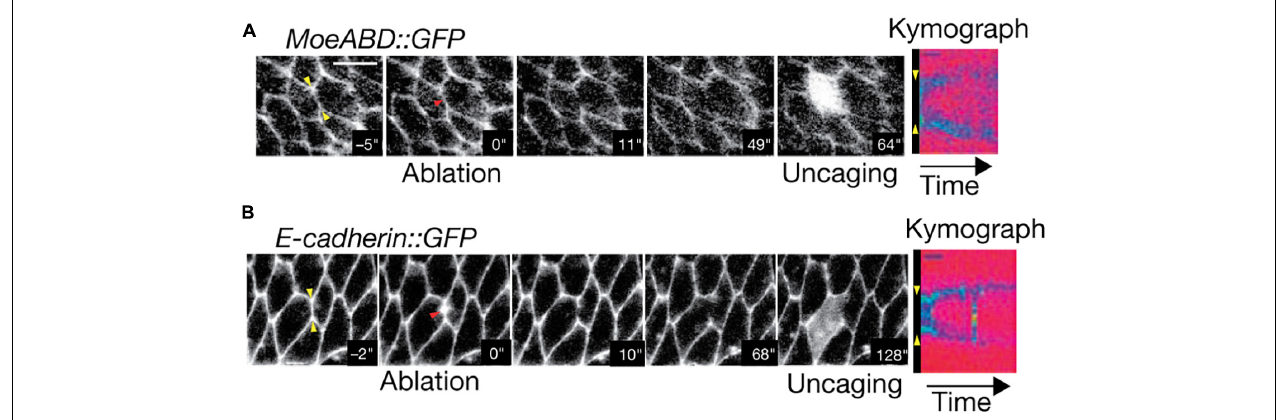
FIGURE 8 | Two-Photon photoablation reveals mechanical tension in vivo . Image sequences of Drosophila embryo expressing (A) MoeABD-GFP and (B) E-cadherin-GFP during 2P photoablation of cell-cell junctions. The red arrow in the second panel from the left represents the site of photoablation. Kymographs at the right (taken at the yellow arrows shown in first panel) show the release and retraction of the ablated region. Uncaging of fluorescein with three-photon microscopy (panel 5) demonstrates that the cell integrity is not disrupted by the photoablation. Scale bar: 5 µ m. Images are reproduced with permission from Rauzi et al.